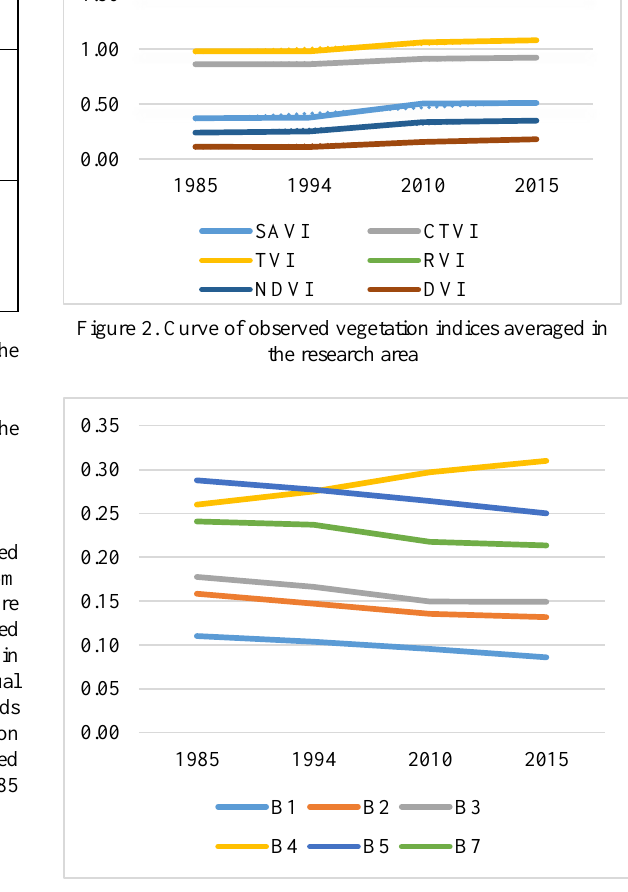
Figure 3. Curve of observed surface reflectance averaged in the research